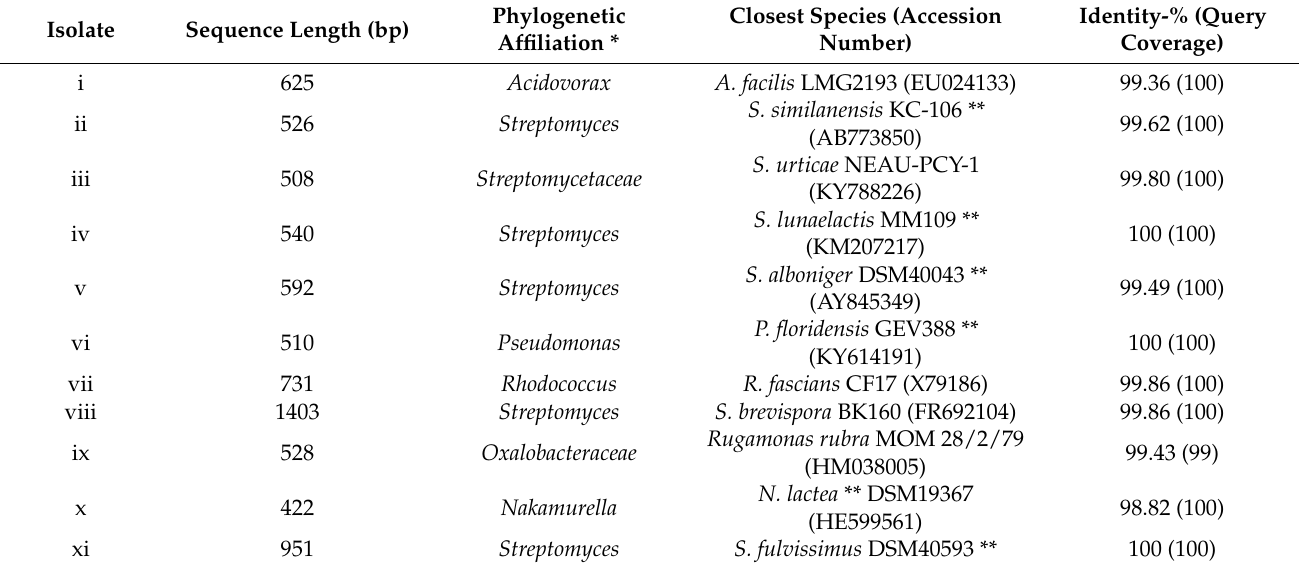
Table 3. Identification of isolates based on partial sequencing of the 16S rDNA